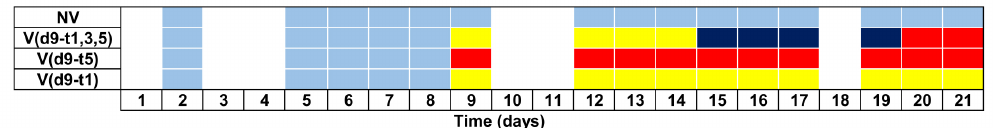
Figure 4. Timeline Experiment 1: Vibration timing/response experiment. White squares denote days with no data acquisition, light blue squares were inspected without vibration ( t = 0 s), yellow squares show the worms stimulated for 1 s ( t = 1 s), dark blue ones for 3 s ( t = 3 s) and red ones for 5 s ( t = 5